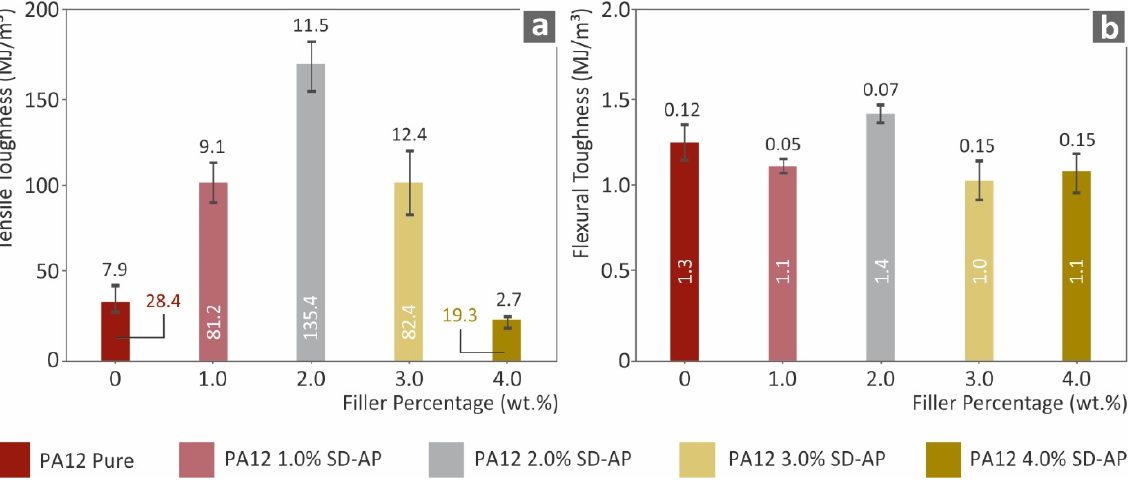
Figure 5. ( a ) Tensile toughness (MJ/m 3 ) to filler loading; ( b ) flexural toughness (MJ/m 3 ) to filler ratio.